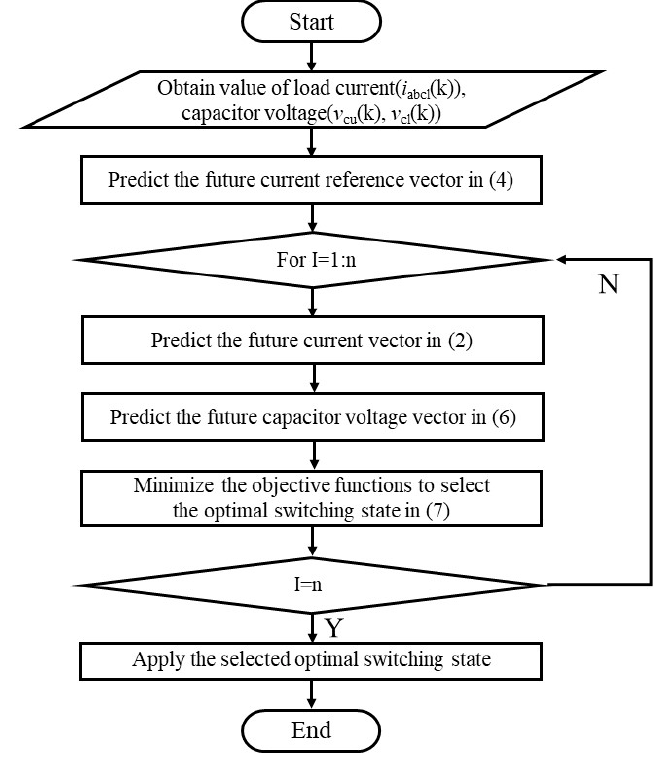
Figure 3. Flowchart of model predictive control applied to this study. Table 1. Input voltage according to the switching state of the two-level three-leg inverter. Voltage